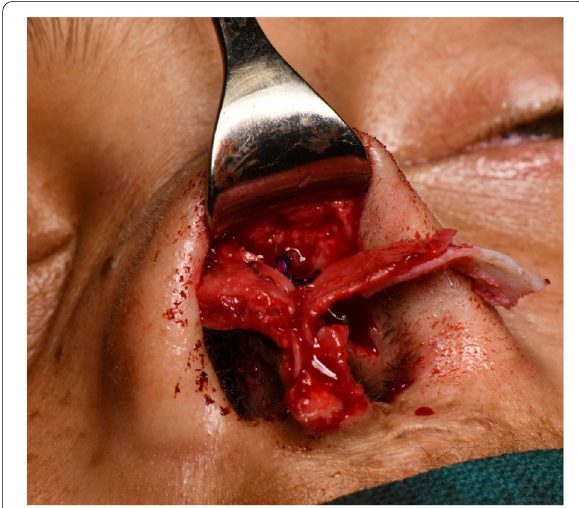
Fig. 4 Nasal tip reconstruction, lateral crural steal, and alar batten graft (sliced rib cartilage)